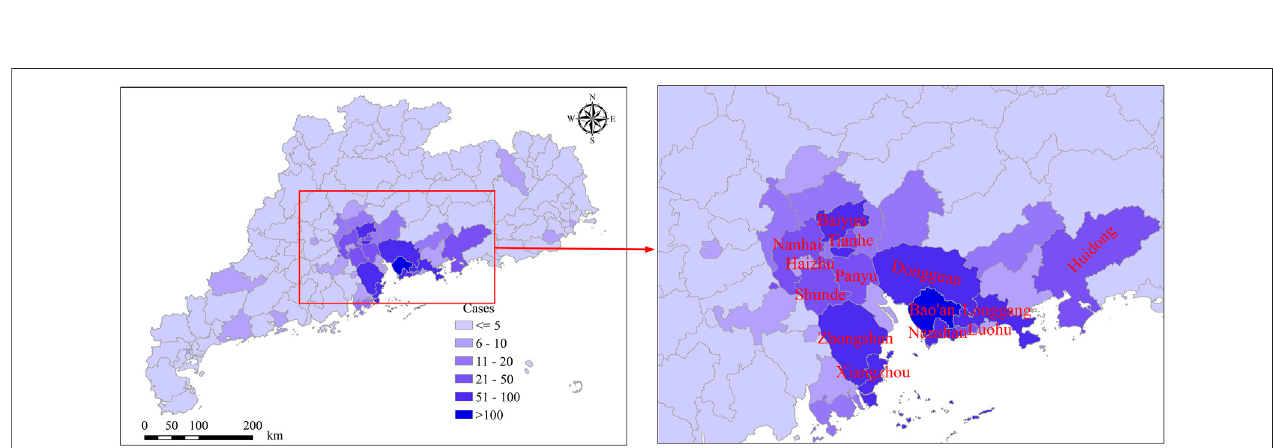
FIGURE 5 | Spatial distribution of county-level COVID-19 con fi rmed cases in Guangdong.